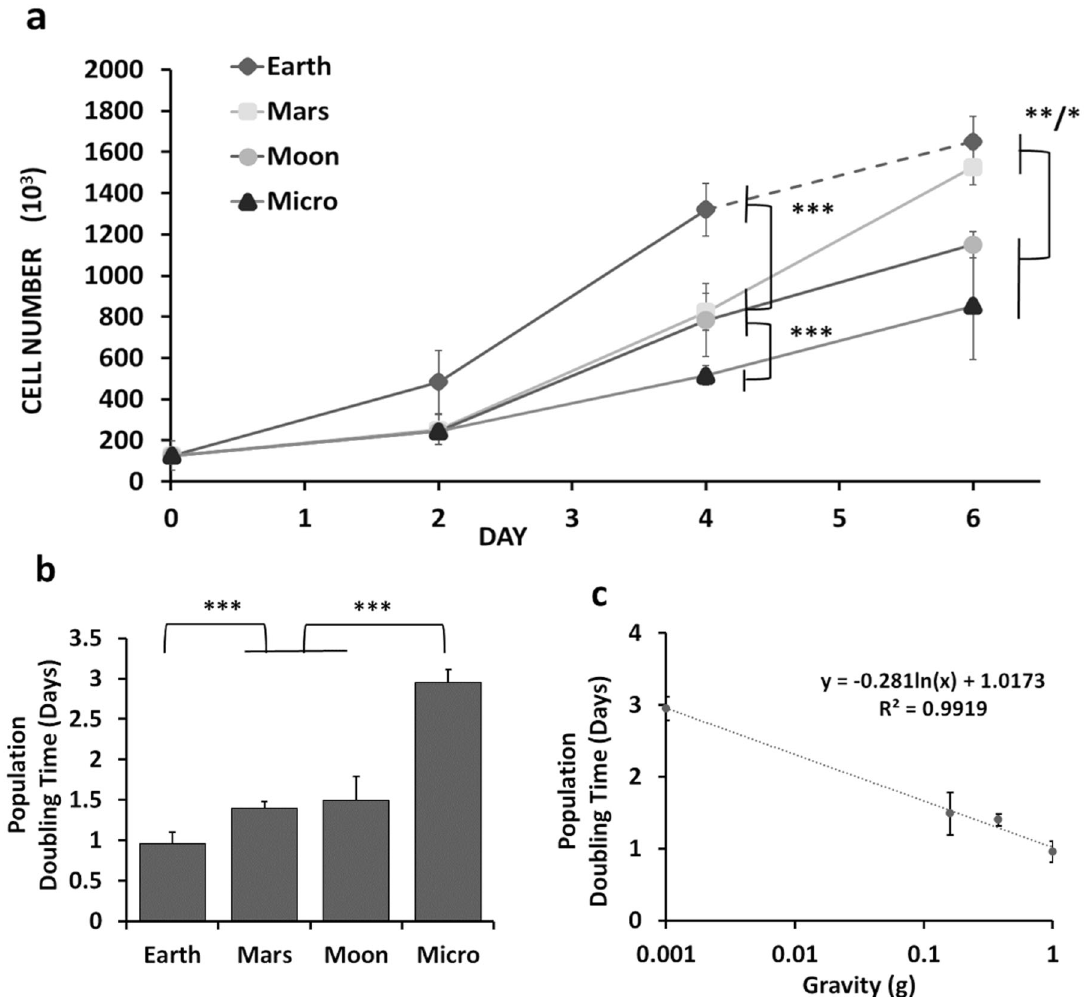
Fig. 1 Inhibition of 7F2 cell proliferation in simulated partial gravity. a Increase in cell numbers on days 2 and 4 of culture in 1 G (Earth) and under the various altered simulated partial gravity conditions (Mars, Moon, Micro) ( N = 3). b Speci fi c partial population doubling times between days 2 and 4 and taking into account the mean absolute error (MAE). The average population doubling times were calculated as 0.96 ± 0.14 days for Earth (1 G), 1.4 ± 0.08 days for Mars, 1.5 ± 0.30 days for Moon, and 2.95 ± 0.17 days for simulated microgravity (Micro). c Semilogarithmic plot of the speci fi c population doubling times vs. simulated partial gravity ( R 2 = 0.9919) for that 48-h window of time. Data are presented as means ± standard deviation. Asterisk (*) shows p < 0.05, (**) shows p < 0.01, (***) p < 0.001 as determined by Tukey ’ s post hoc analysis (panels ( a ) and ( c )) or mean absolute error (MAE) (panel ( b